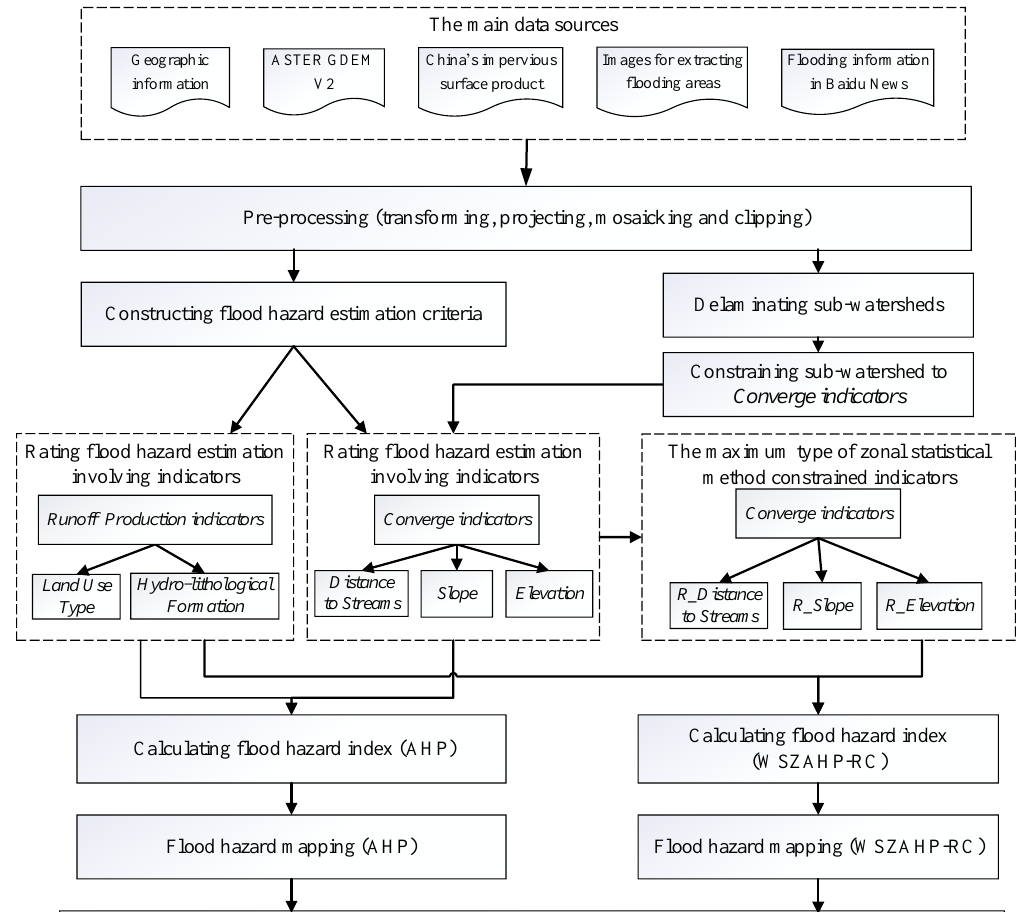
Figure 2. The overall workflow of our study.